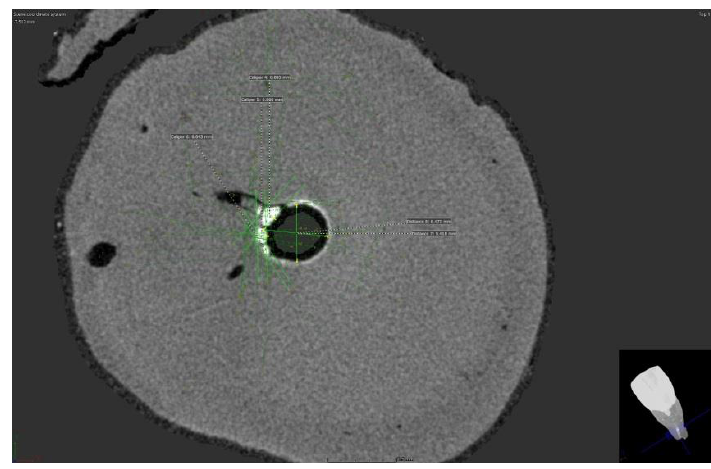
Figure 2. Micro CT scan of sample with preserved smear layer.